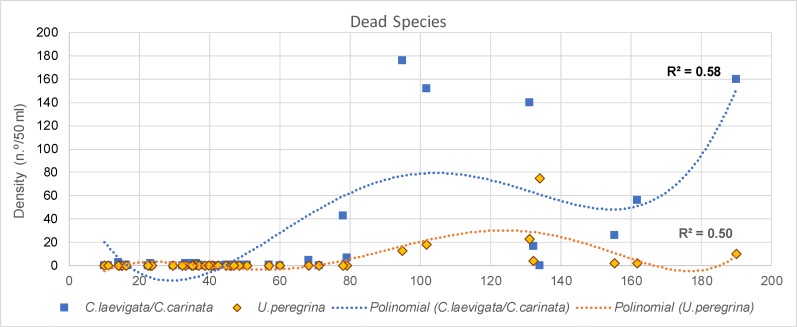
Density (SD; n.°/50 ml) of dead individuals of C. laevigata/C. carinata and U. peregrina as a function of the depth.Polynomial trend lines are presented.